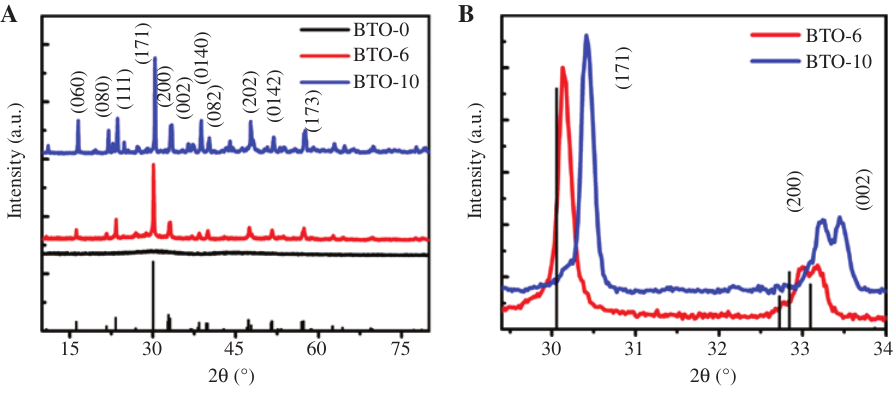
Figure 1: Structural characterization of the prepared samples and ferroelectric composite. (A) The XRD pattern of BTO-j (j = 0, 6, and 10) samples. (B) The partially amplified XRD patterns of the prepared BTO-j